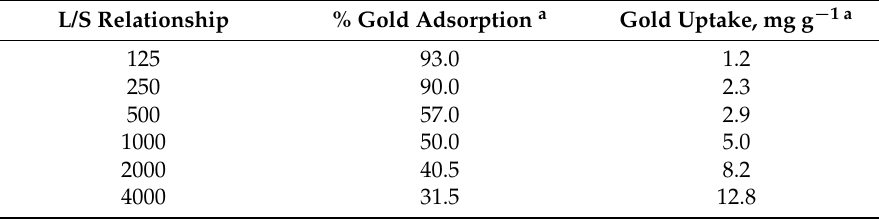
Table 4. Influence of the liquid/solid relationship on gold(I) adsorption.